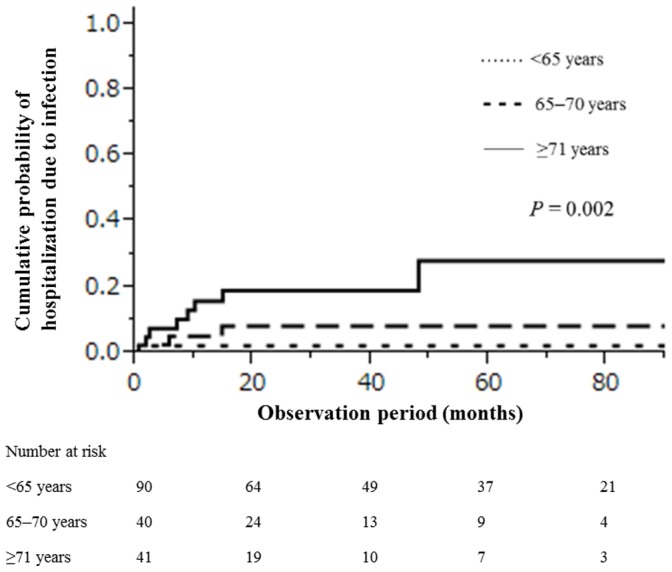
Cumulative probability of hospitalization due to infection in 171 IMN patients stratified by age.